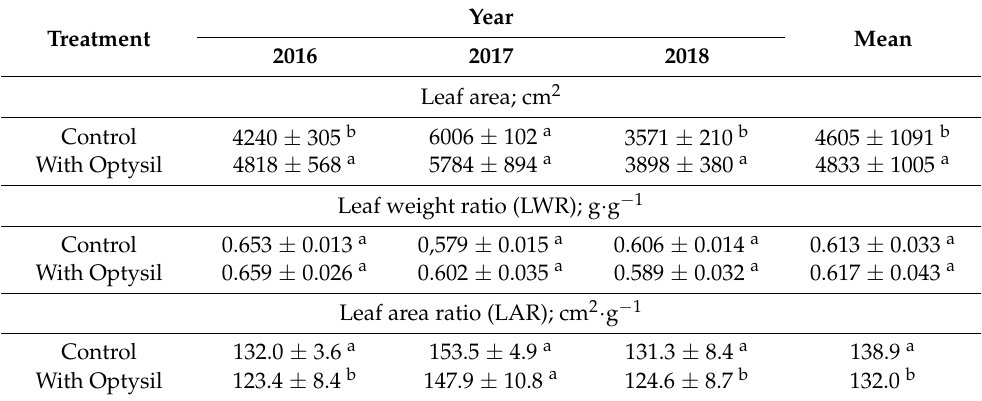
Table 5. Effect of Optysil on leaf area, leaf weight ratio (LWR) and leaf area ratio (LAR).